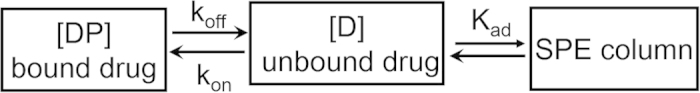
The interaction process in protein-drug-SPE column system.